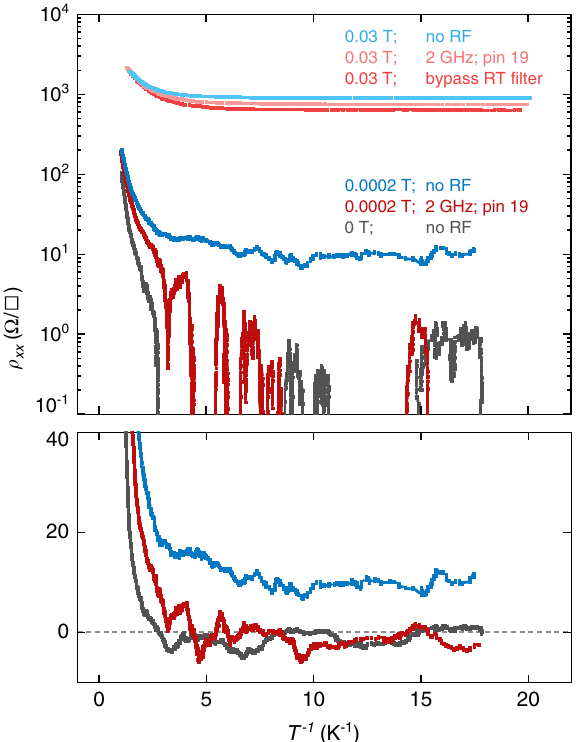
Fig. 6 Radio-frequency (RF) signal and broadband noise enhan- cing tendency toward superconductivity. Enhanced conductivity by coupling RF signal to the sample S2G, at 0.03 and 0.0002 T. In the latter case, a zero-resistance state emerges as a result of injecting 2 GHz signal. Lower panel shows 0.0002 T data in linear scale, further demonstrating the effect of RF injection. ‘ No RF ’ means zero output power at RF signal generator. ‘ Pin 19 ’ denotes a voltage lead connected to the sample in the middle along the Hall bar, see Fig. 1d. ‘ Bypass RT fi lter ’ means RT fi lter is bypassed and broadband noise enters signal line. (No RF signal is injected in this case; data smoothed for higher visibility.) Other wires are checked for decoupling from the sample at RF. See Supplementary Figs. 4 and 5 for an estimate of RF power transmitted to the sample and RF injection results in insulating